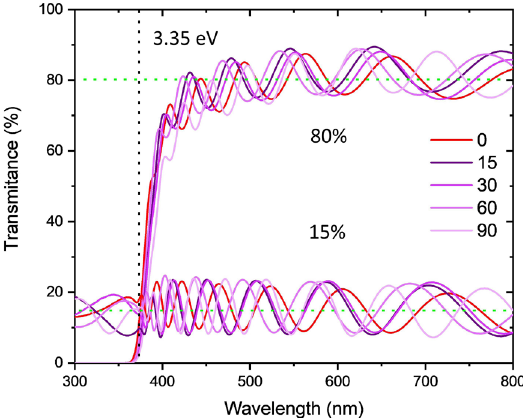
Figure 4. Optical transmittance and reflectance spectra for the ZnO/glass and the SnO /ZnO/glass samples. 2